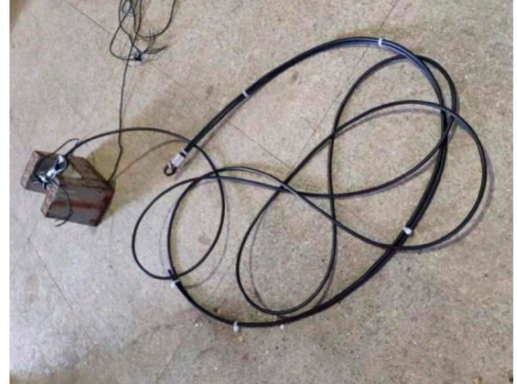
Figure 7. Wave altimeter. Figure 8. Wire rope and mooring block. Figure 8. Wire rope and mooring block. Figure 8. Wire rope and mooring